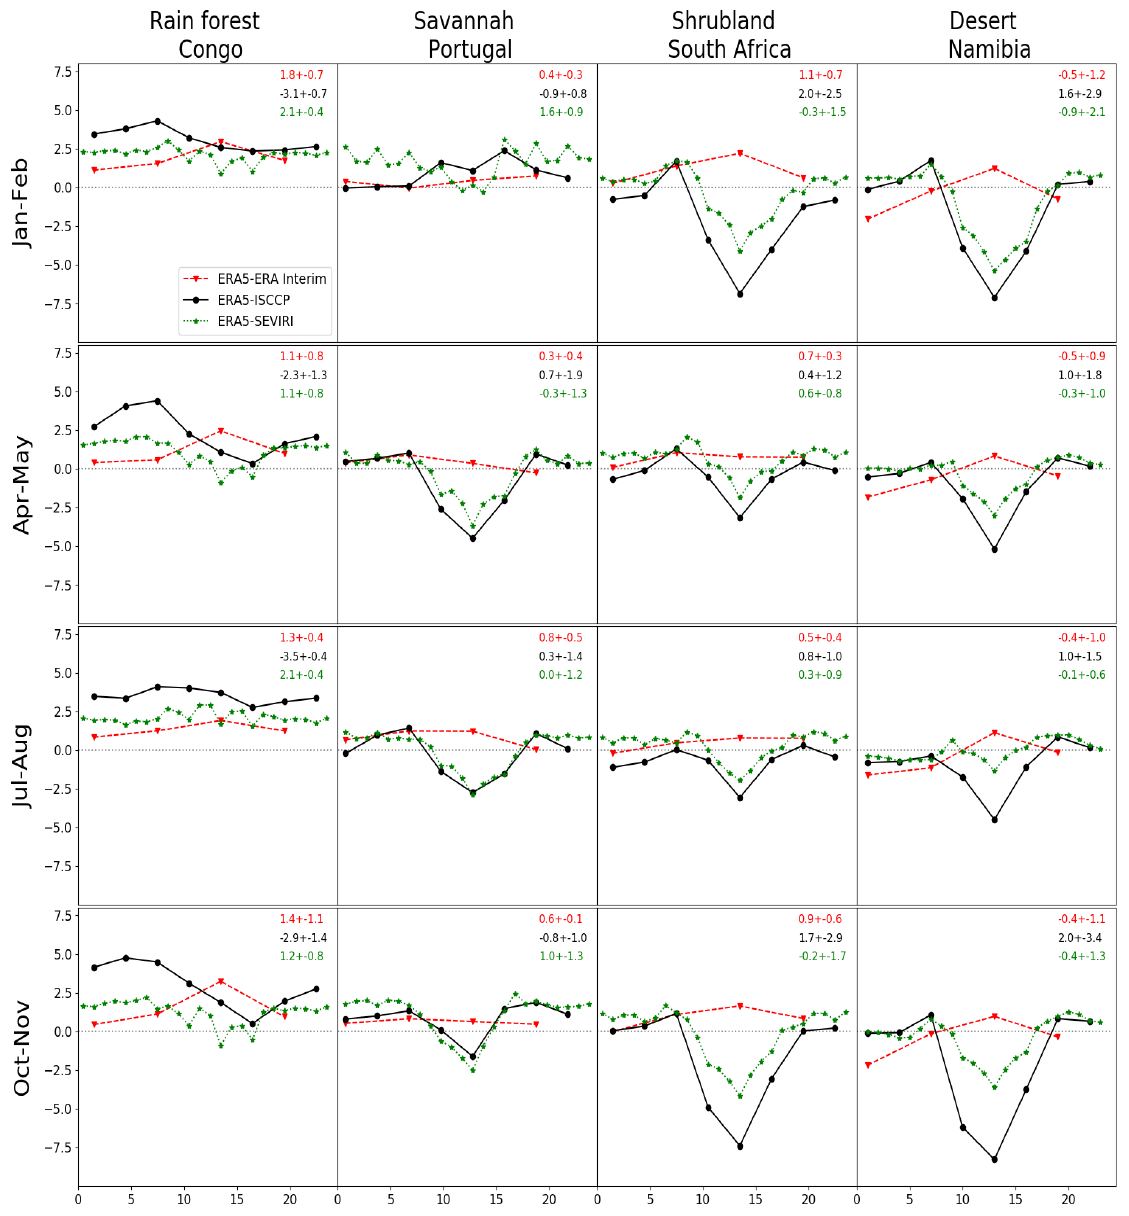
Figure 4. Diurnal LST bias variations (unit: K) for ERA5-ERA Interim, ERA5-ISCCP, ERA5-SEVIRI over four selected vegetation types in January–February, April–May, July–August, and October–November in 2010. X -axis represents local time. The columns represent four selected regions, and the rows for the four